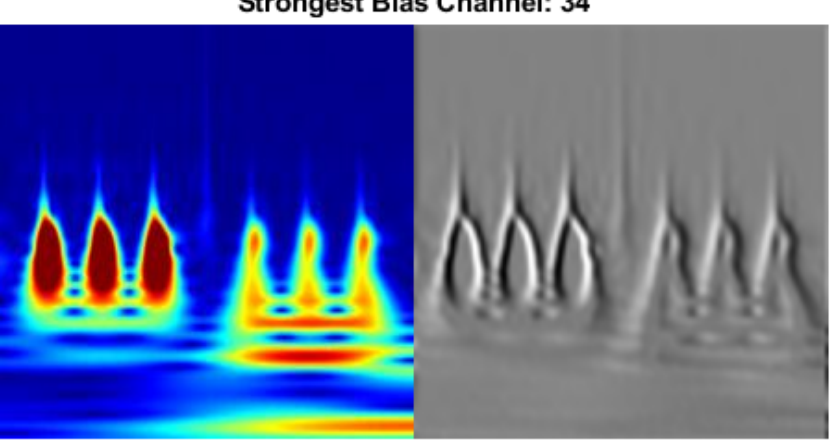
Figure 16. The strongest channel for sensor bias fault scenario.